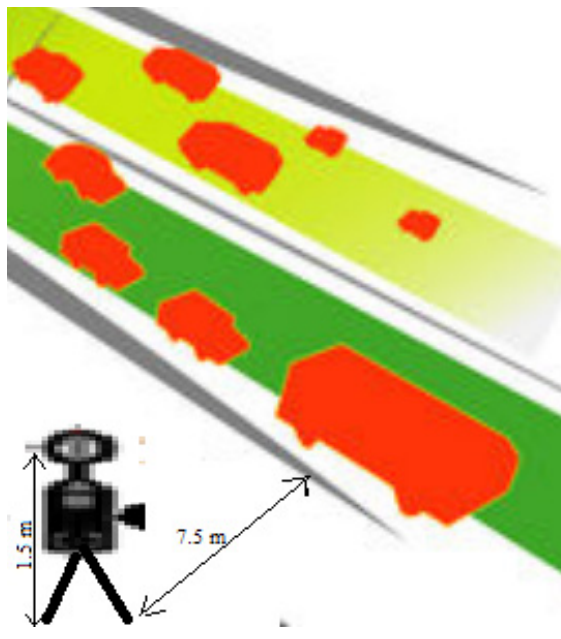
Figure 3. Noise measurement scheme.